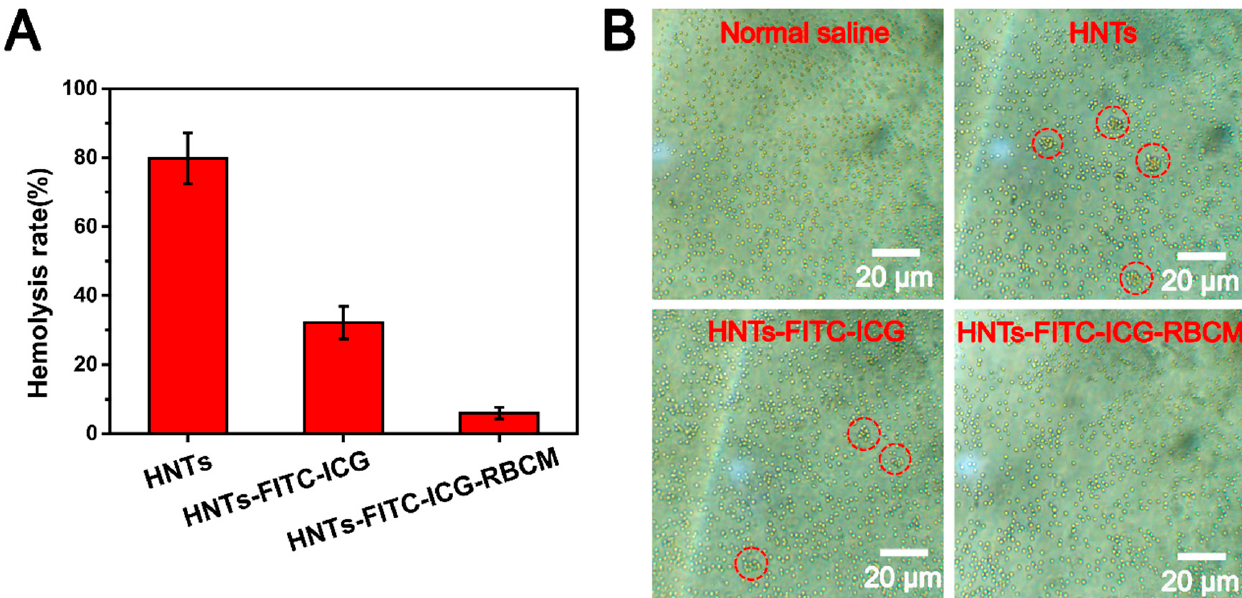
Figure 4. Hemolysis rate ( A ) of HNTs, HNTs-FITC-ICG and HNTs-FITC-ICG-RBCM and red blood cell images ( B ) interacted with different particles for 24 h. The red circles represent the aggregated red blood cells.